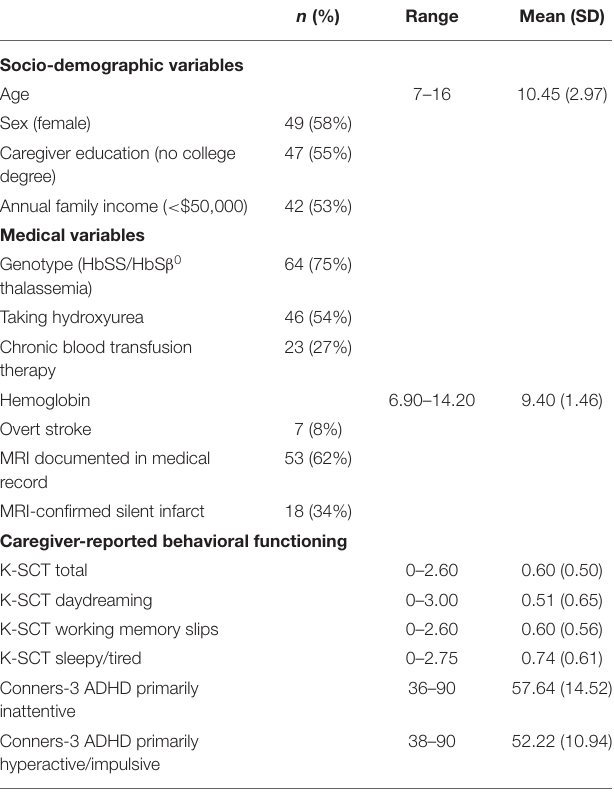
TABLE 1 | Descriptive characteristics of the study